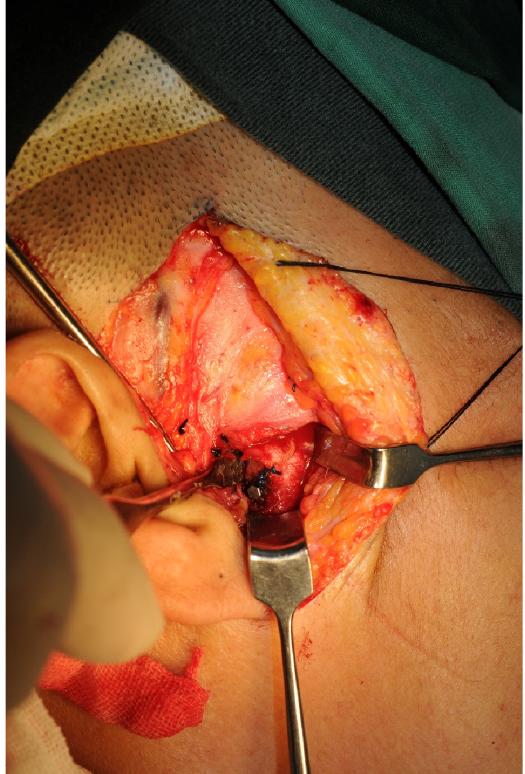
Figure 2. The anterior disc displacement was released and fixed on an anchor. J. Clin. Med. 2023 , 12 , 1657